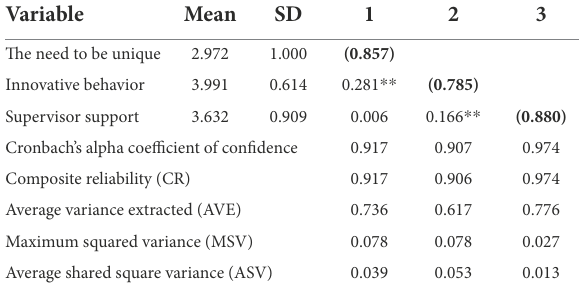
TABLE 1 Data with mean, standard deviation, correlation coefficients, confidence and discrimination validity.